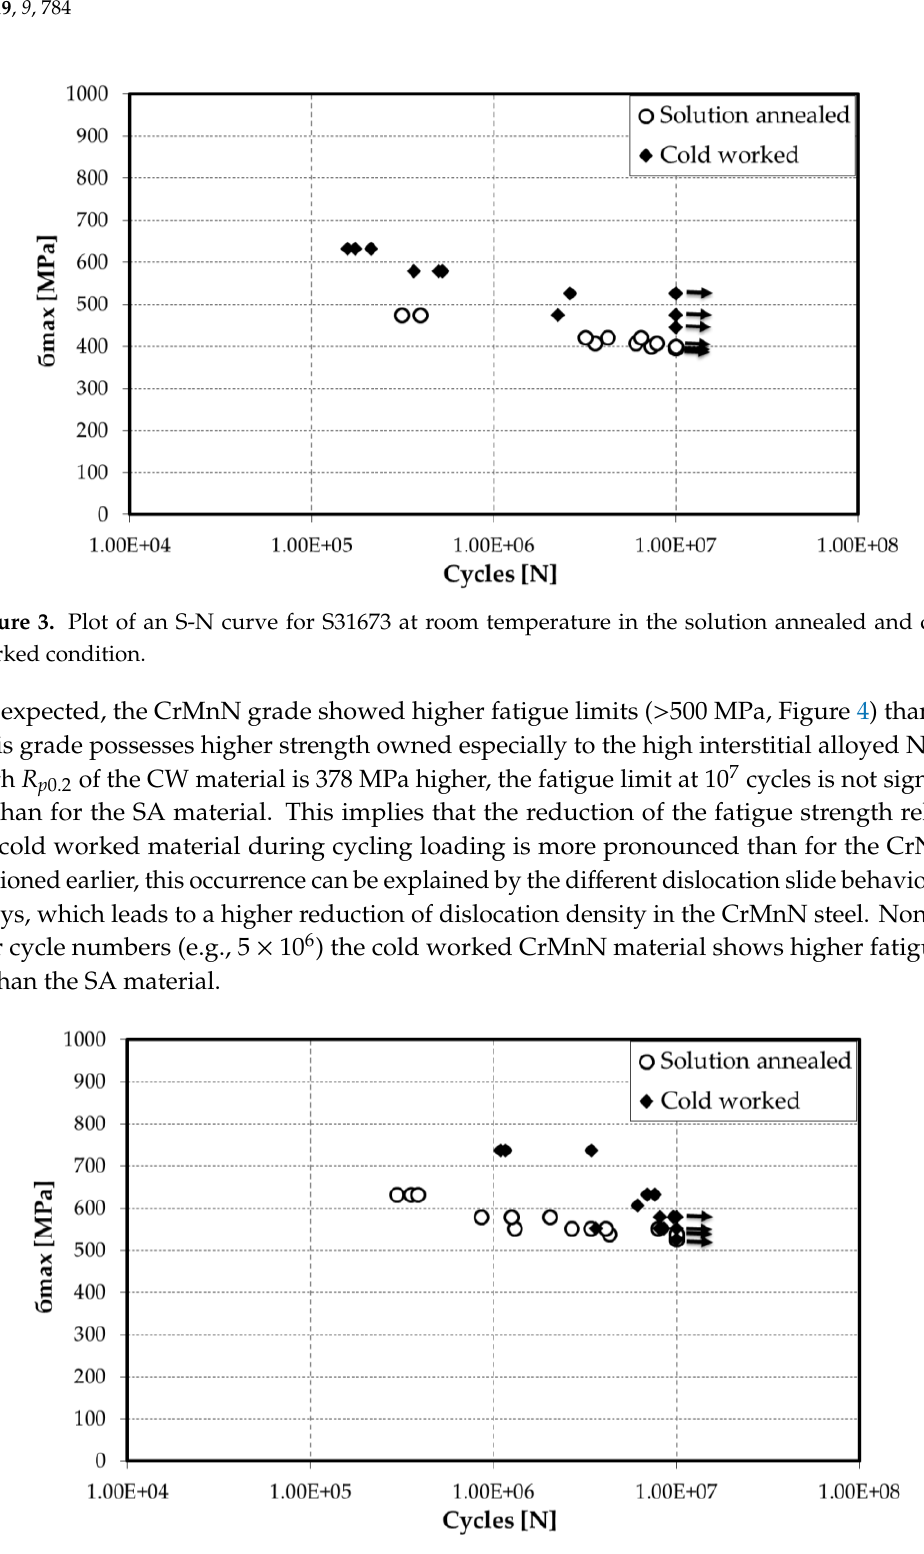
Figure 4. Plot of an S-N curve for CrMnN at room temperature in the solution annealed and cold worked condition.